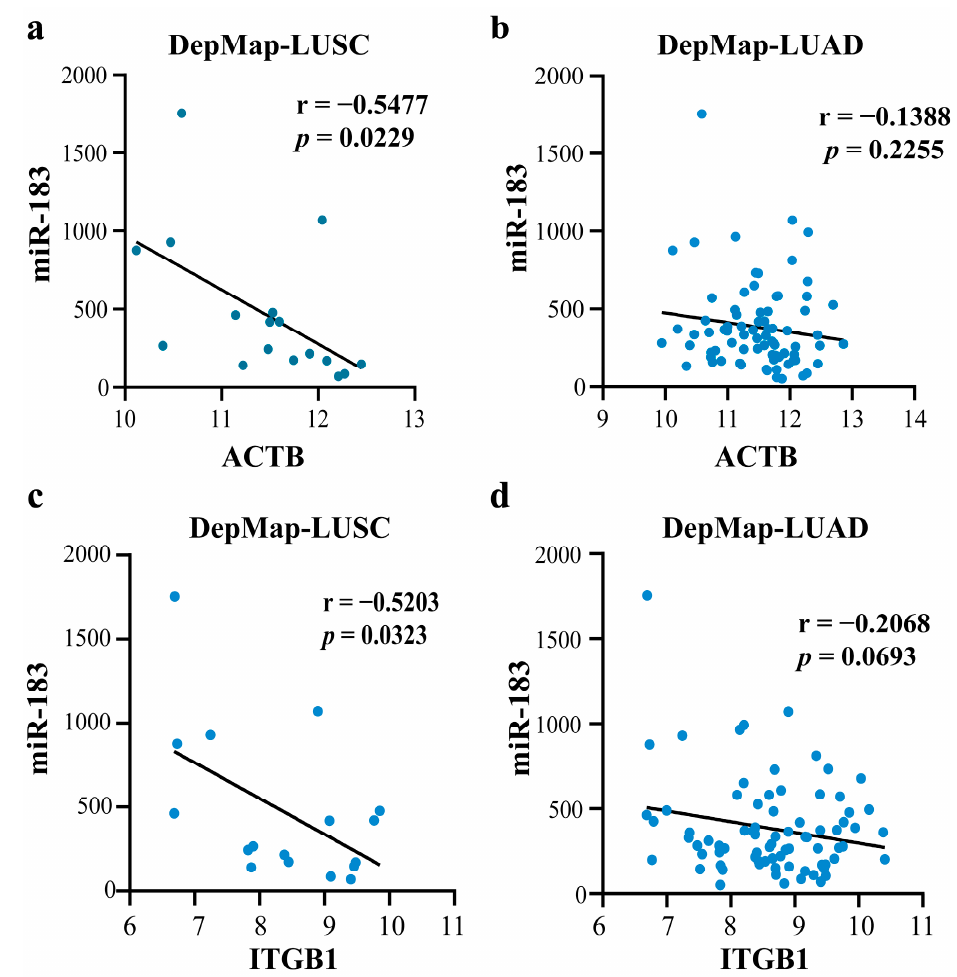
Figure 16. The correlations between miR-183 and ACTB, miR-183 and ITGB1 in NSCLC cell lines: ( a ) The correlation between miR-183 and ACTB of LUSC cell lines; ( b ) The correlation between miR-183 and ACTB of LUAD cell lines; ( c ) The correlation between miR-183 and ITGB1 in LUSC cell lines; ( d ) The correlation between miR-183 and ITGB1 of LUAD cell lines.